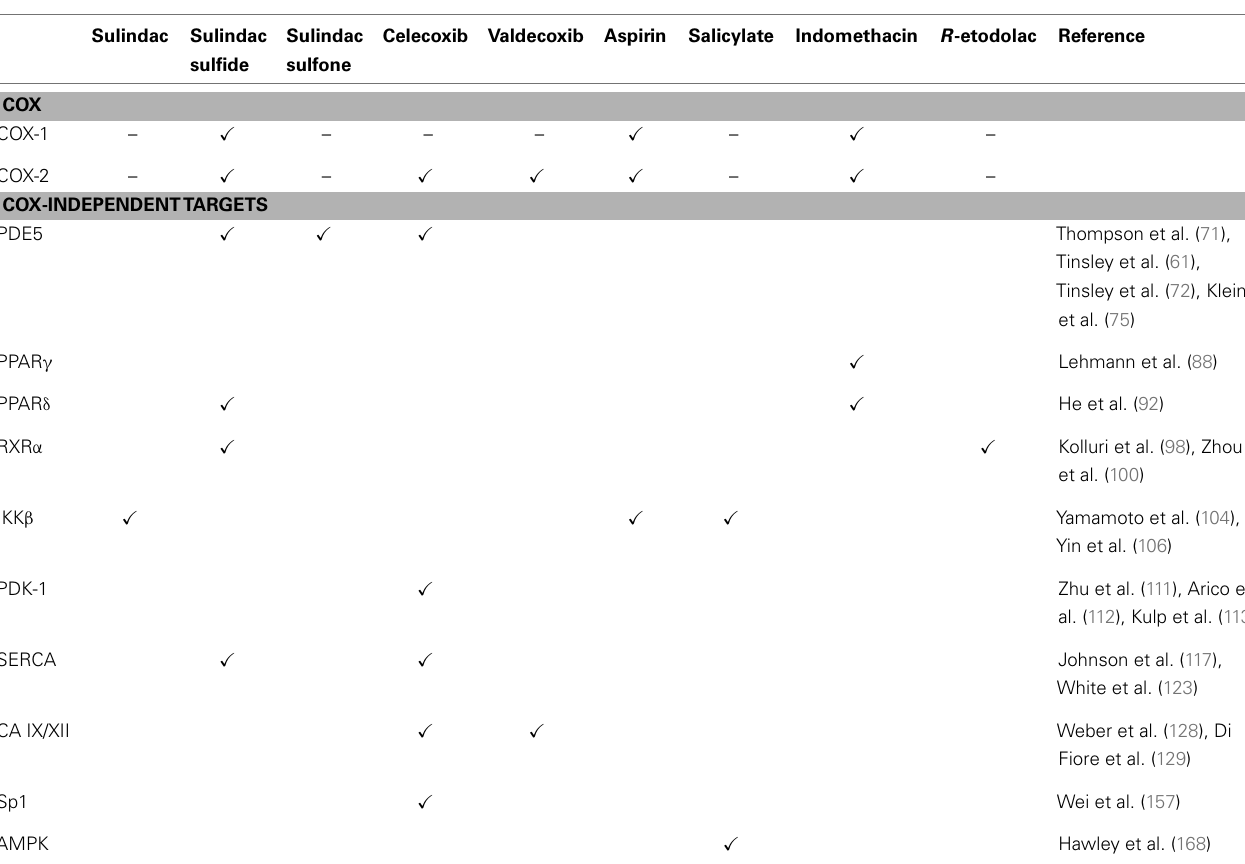
Table 3 | Cyclooxygenase-independent direct cellular targets of NSAIDs and